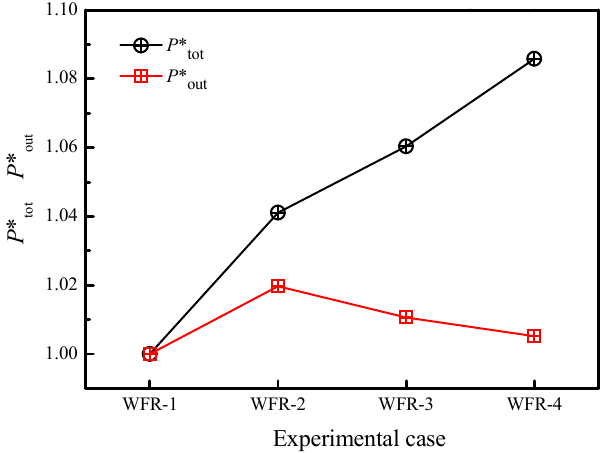
Figure 7. Influence of the water mass flow rate on SPTEG